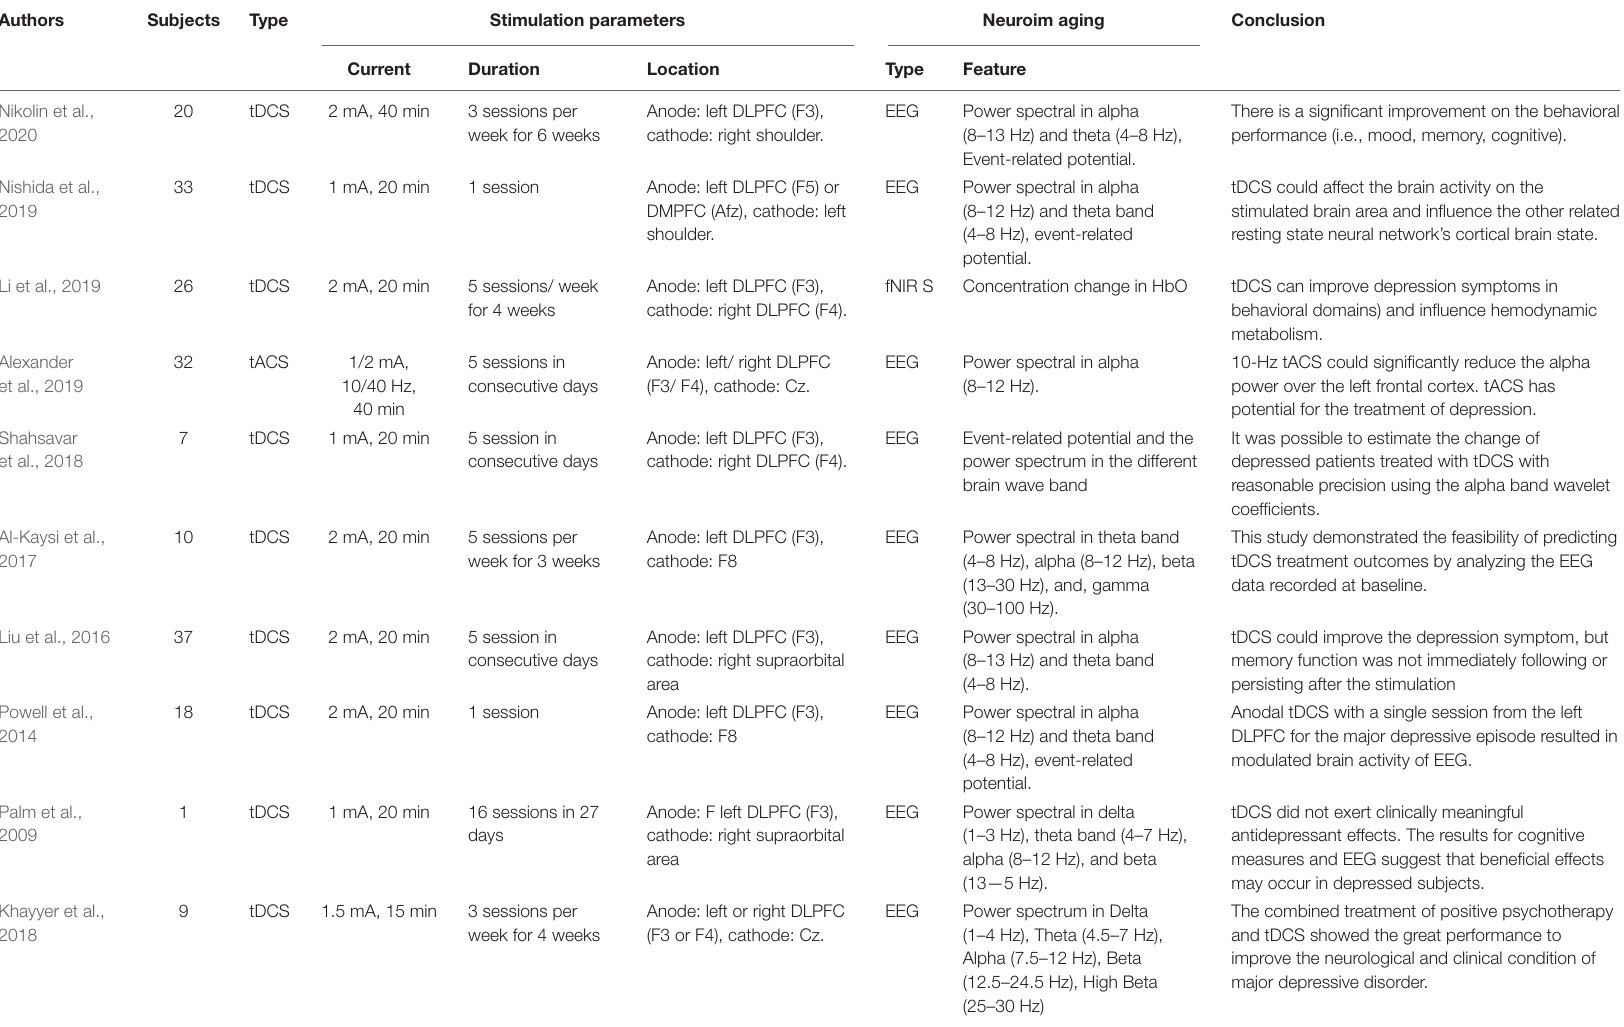
TABLE 2 | Studies and experimental characteristics of the tES literature for